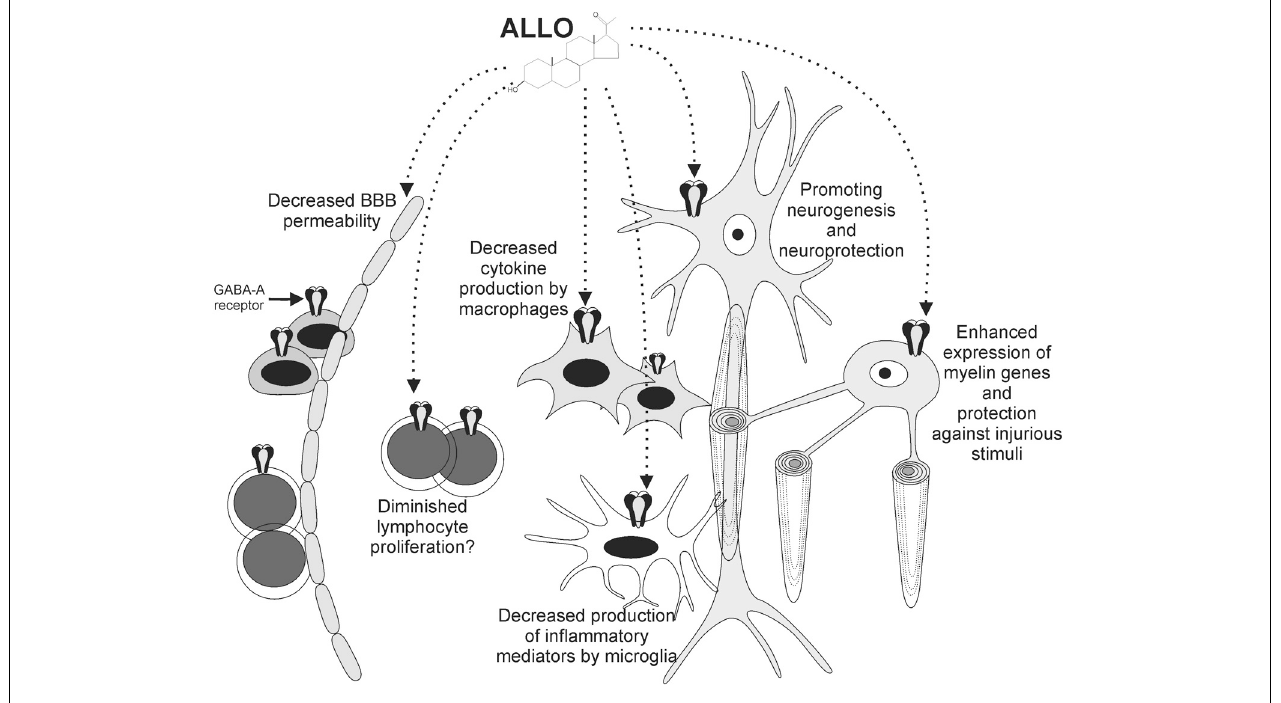
FIGURE 1 | ALLO exerts various effects on cells involved in MS pathogenesis. Functional GABA-A receptors are expressed by neurons, oligodendrocytes, monocytoid cells, and lymphocytes. ALLO promotes myelin gene expression by oligodendrocytes and protects them against injurious stimuli. Neuroprotective effects have also been reported for